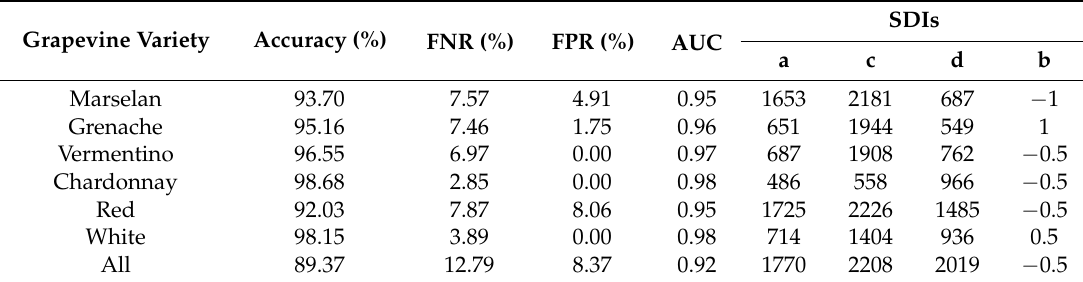
Table 11. Results of using SDIs in classifying different groups of spectral data acquired in the August and the September acquisition campaigns (Severity of infestation = 1 &